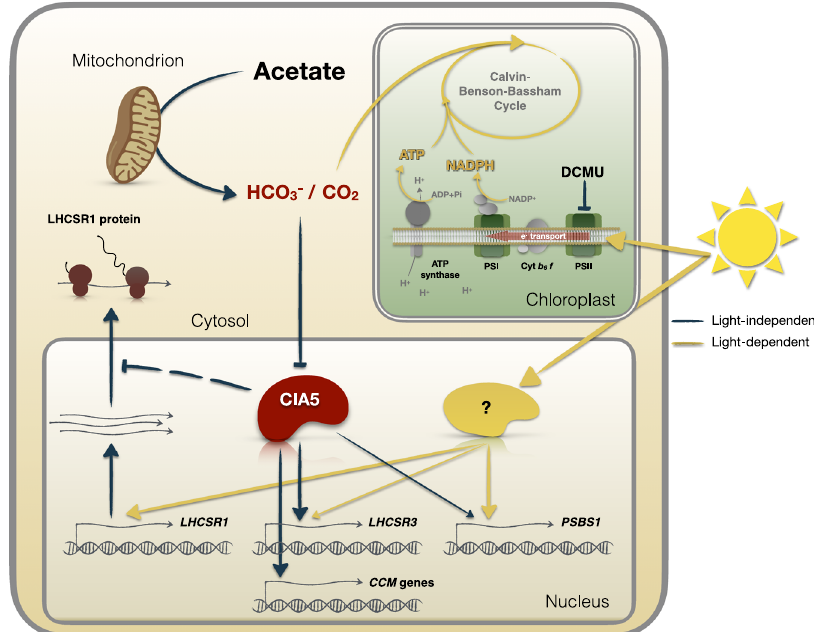
Fig.7|CO 2 -andlight-dependentsignalsconvergetoregulatephotoprotection and CCM in Chlamydomonas. The intracellular levels of CO 2 , de fi ned by the equilibrium between CO 2 fi xation in chloroplasts and the generation of CO 2 by mitochondrial metabolism (e.g. acetate assimilation) is the key determinant of the regulation of gene expression controlling two major processes of photosynthetic organisms: CCM and photoprotection. Changes in light availability have a direct impact on intracellular CO 2 levels; exposure to HL increases CO 2 fi xation rates leadingtodepletionofCO 2 andtoactivationofnotonlyphotoprotection-butalso CCM-related genes. Conversely, depletion of CO 2 is suf fi cient to drive